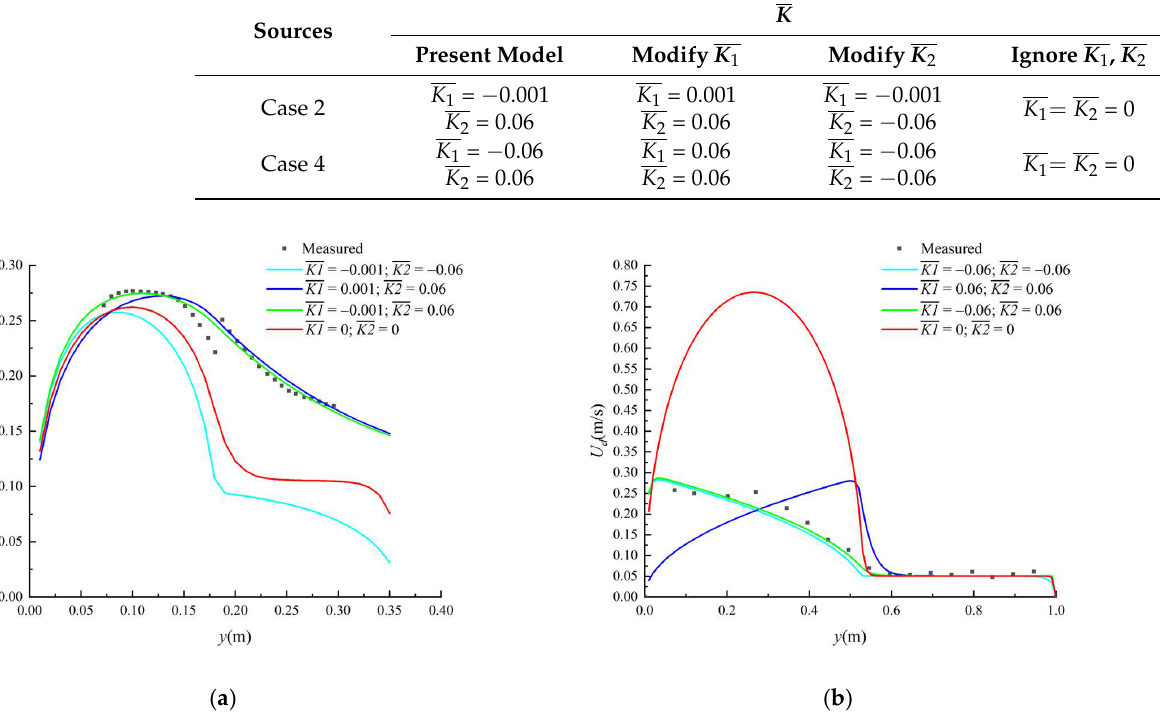
Figure 6. Effect of the secondary flow coefficient, K , on the results of the model for the prediction of the transverse distribution of water depth-averaged streamwise velocity with submerged vegetation. ( a ) For case 2, in the presented model, K 1 = − 0.001 and K 2 = 0.06. ( b ) For case 4, in the presented model, K 1 = − 0.06 and K 2 =